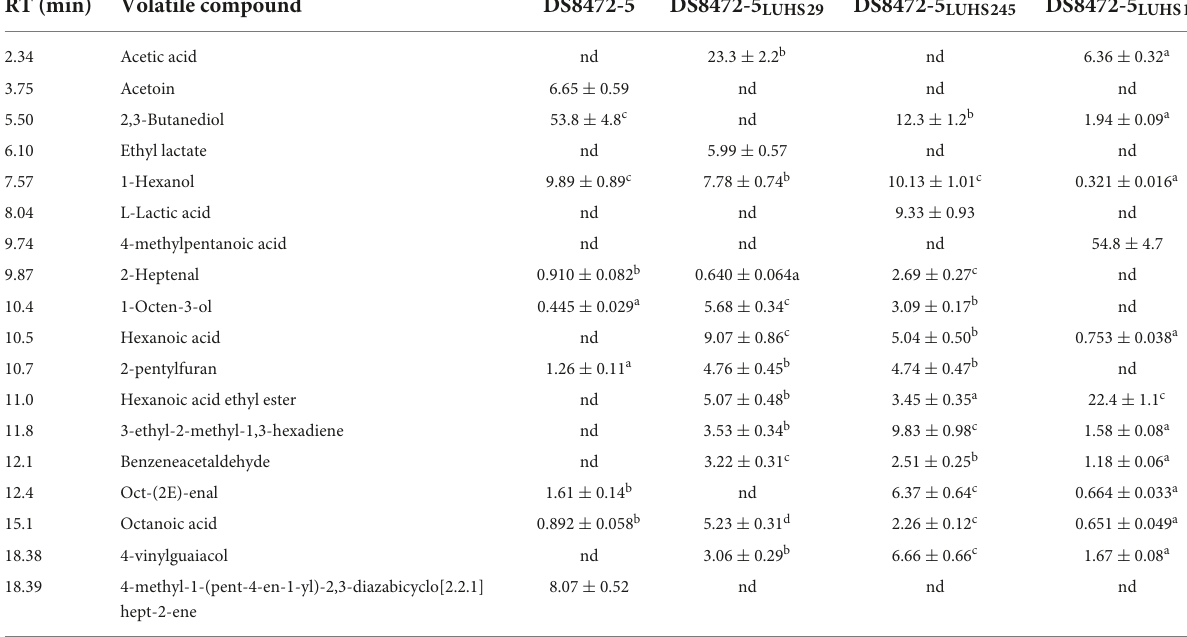
TABLE 4 Volatile compounds (VC) present in at least one wheat cereal wholemeal (WCW) (DS8472-5) sample at >